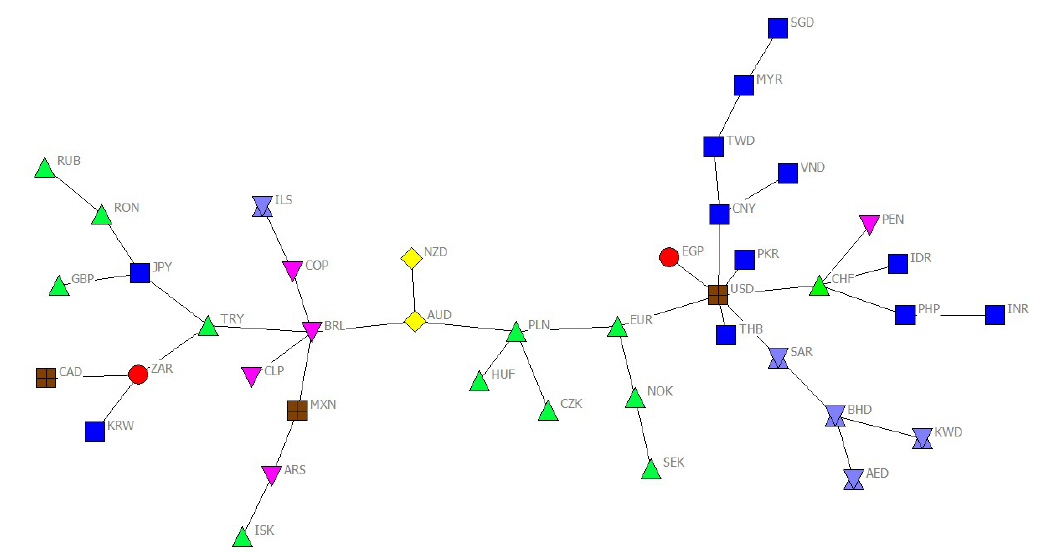
Figure 2. FX network during 18 March 2008–21 October 2008, as a representative of sub-prime crises. FX markets from the same region are labeled with the same color and shape (i.e., Africa, red circles; Asia, blue squares; Europe, green up triangles; Middle East, light blue things; North America, gray boxes; South America, pink down triangles; Oceania, yellow diamonds) henceforth.